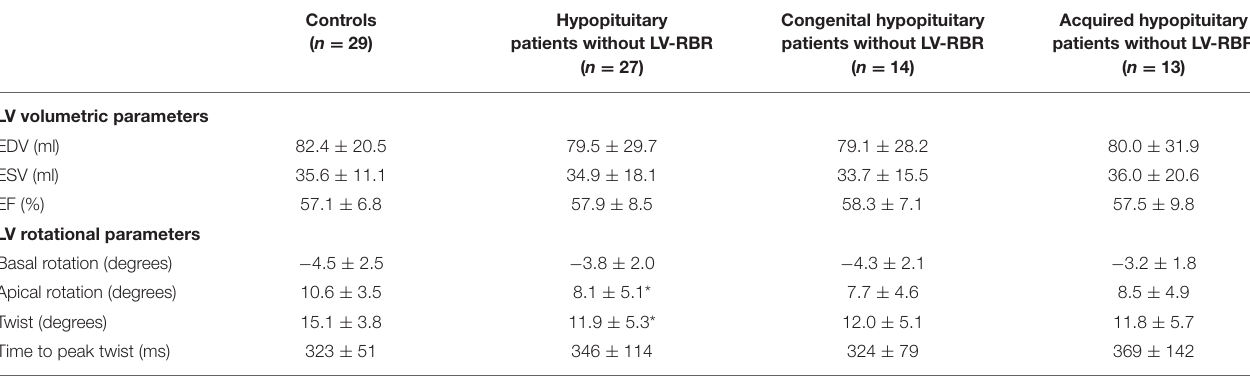
TABLE 3 | Comparison of three-dimensional speckle-tracking echocardiography-derived left ventricular volumetric and rotational parameters between those of patients with hypopituitarism and controls.